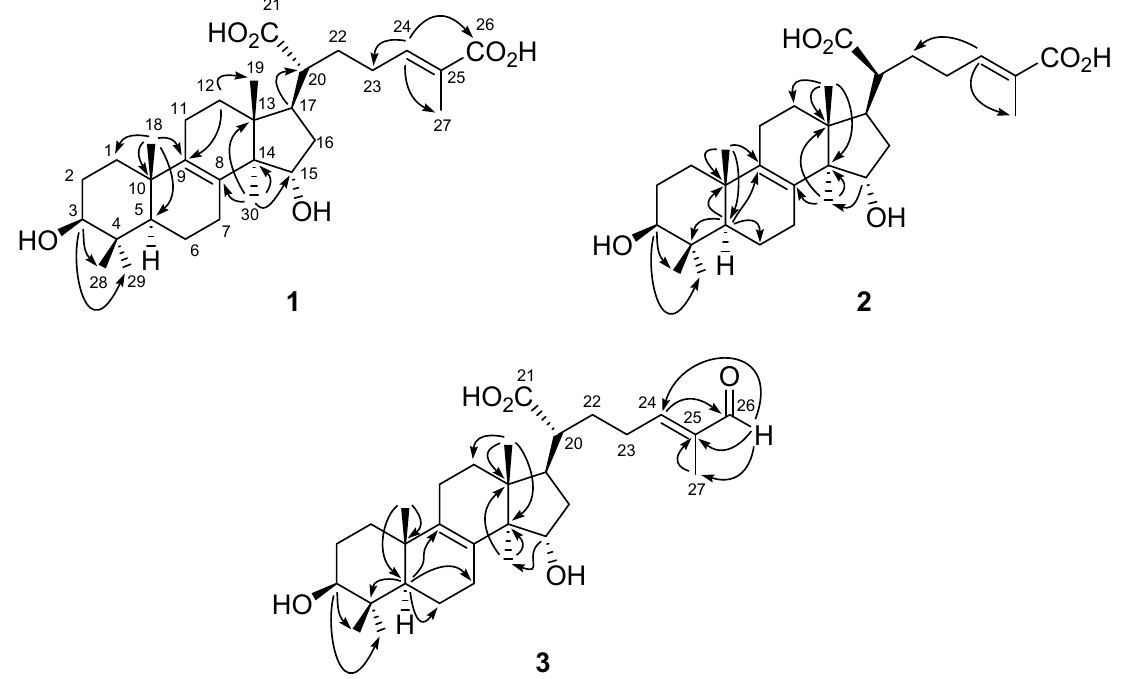
Figure 2. Structures and key HMBC correlations ( → ) of compounds 1 – 3 .